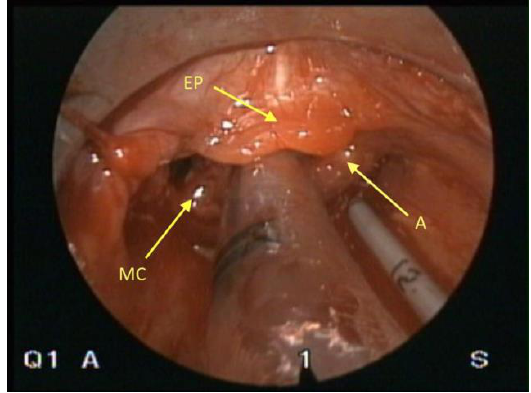
Figure 3: Endoscopic view of the larynx after marsupialization (MC; Marsupialized Cyst, A; Arytenoid cartilage, EP;